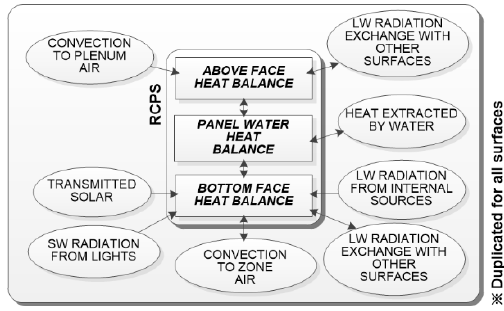
Figure 4. Simplified heat transfer model of test room equipped with CRCP.